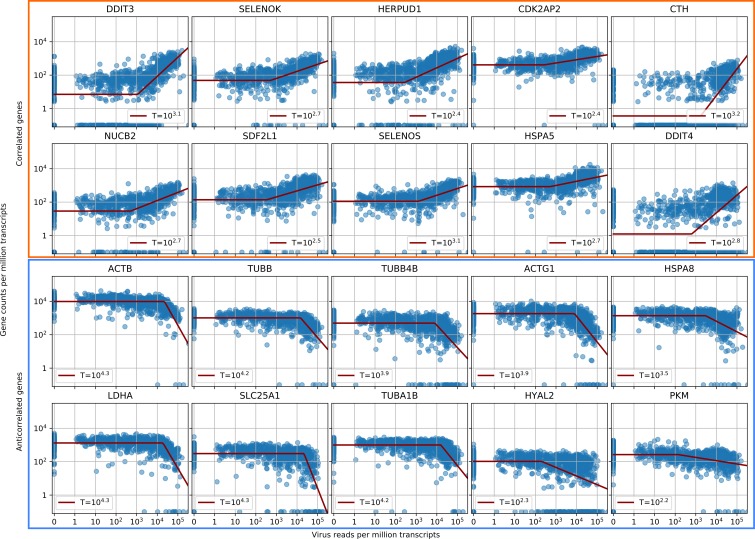
Parametric fitting of piecewise-linear gene expression versus intracellular virus amount infers reaction thresholds for infected cells.The top rows show the most positively correlated genes, the two bottom rows the most anticorrelated genes (see Figure 2A, insets).